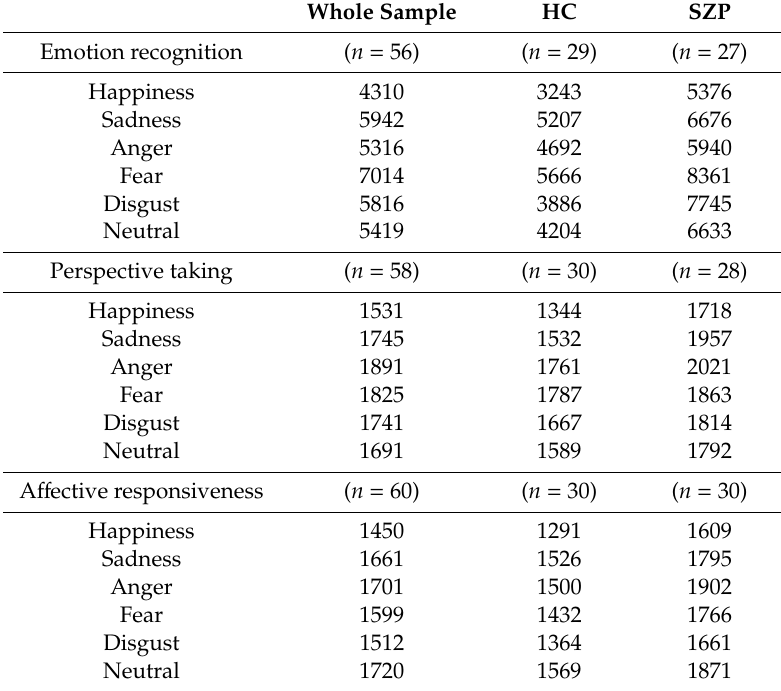
Table 3. Reaction times across the whole sample and for the two subgroups (presented as Mean [SD] in